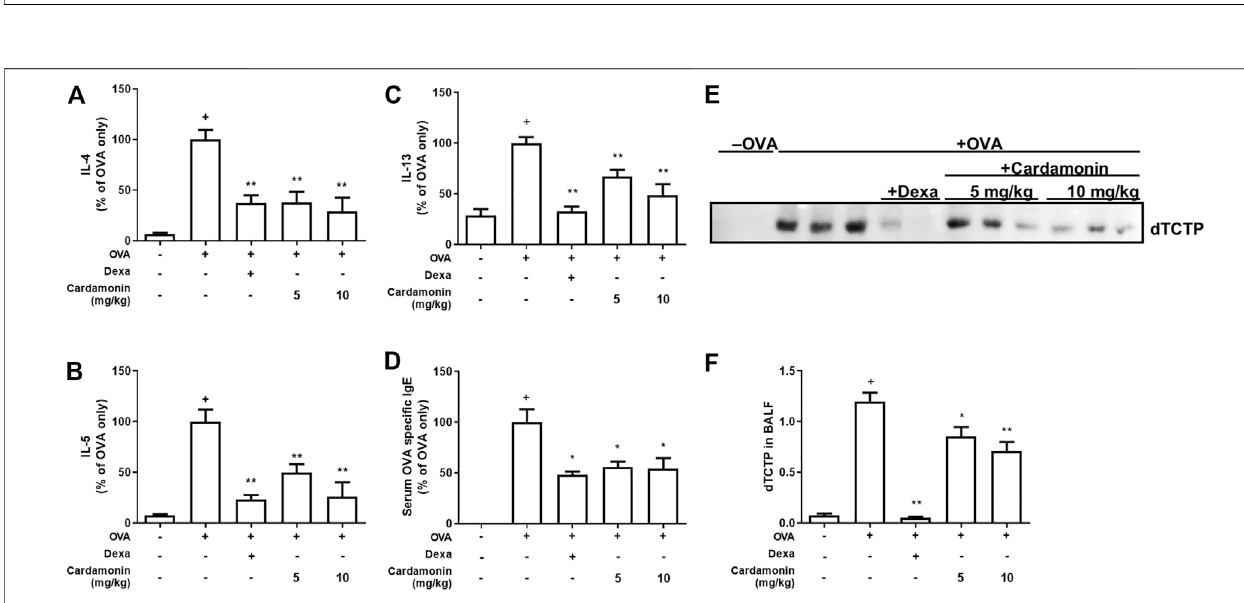
FIGURE 4 | Cardamonin has anti-in fl ammatory effects in a dose dependant manner. The levels of IL-4 (A) , IL-5 (B) , IL-13 (C) , and serum levels of OVA- speci fi c IgE (D) were measured by ELISA after sacri fi ce. The levels of IL-4, IL-5, IL-13, and OVA speci fi c IgE were increased signi fi cantly in OVA-treated mice; however, the increased levels of these cytokines were signi fi cantly suppressed by cardamonin treatment. BALF was concentrated and immunoblotted for TCTP (E) . The quantitative results areshown in (F) . Thevalues shown are means ± SEM. n (cid:1) 3 – 6, + p < 0.05comparedwiththe sham group; * p < 0.05, ** p < 0.01 compared with the vehicle group treated with